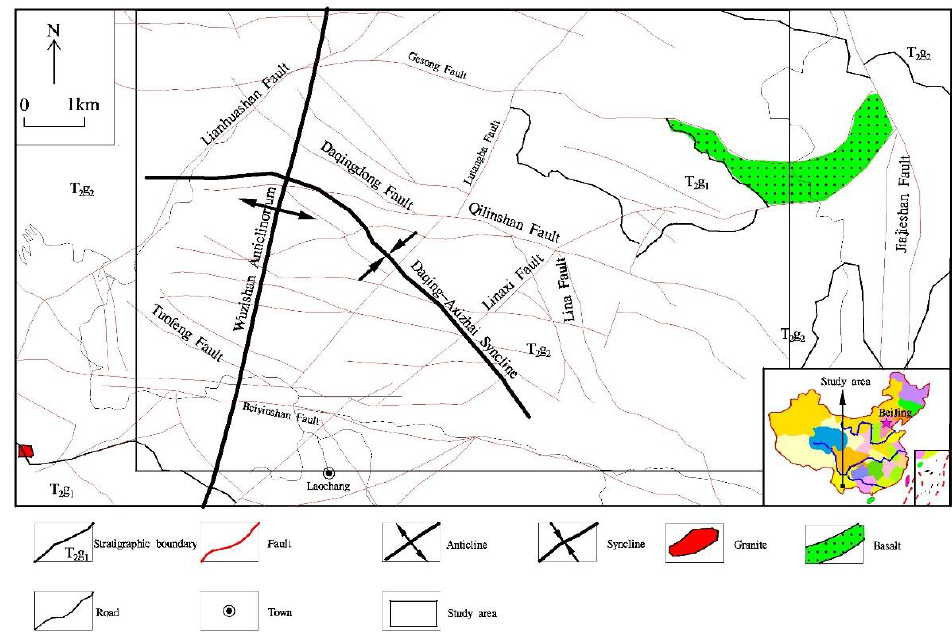
Figure 1. Distribution of fracture structure in the Gaosong ore field.